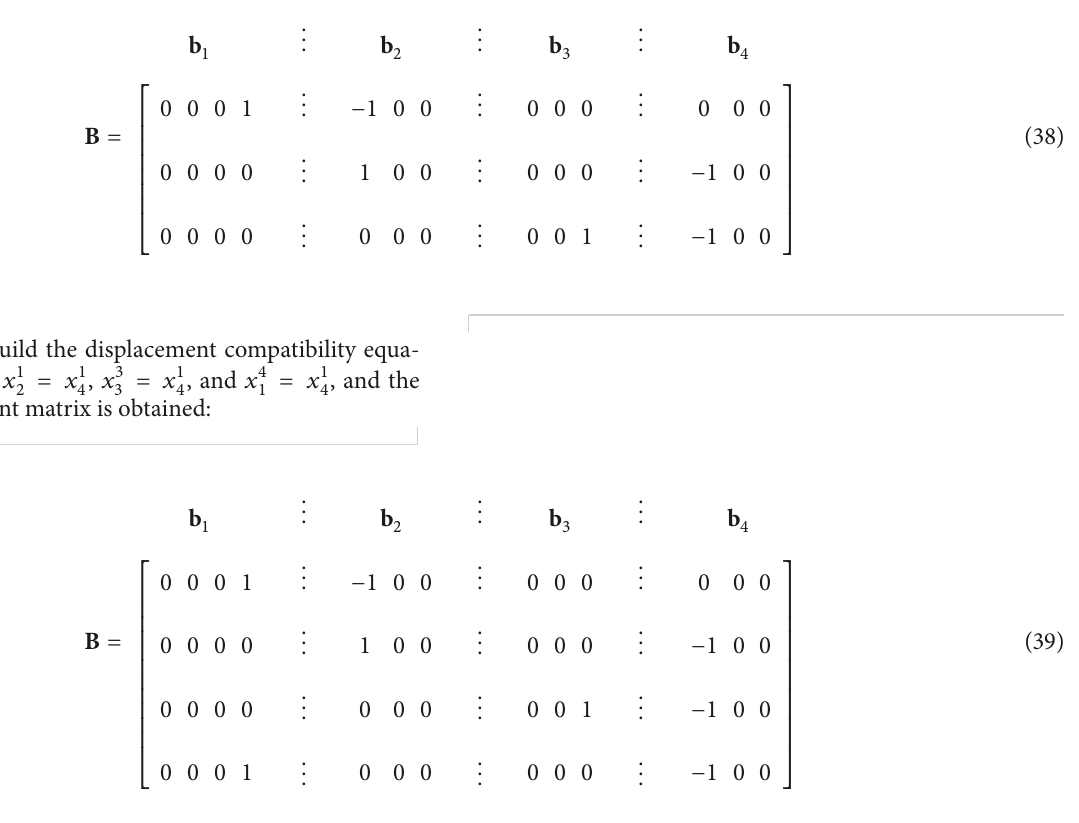
The DOFs are numbered from the 1st to 10th. Partition the assembly into 4 components or substructures, as shown